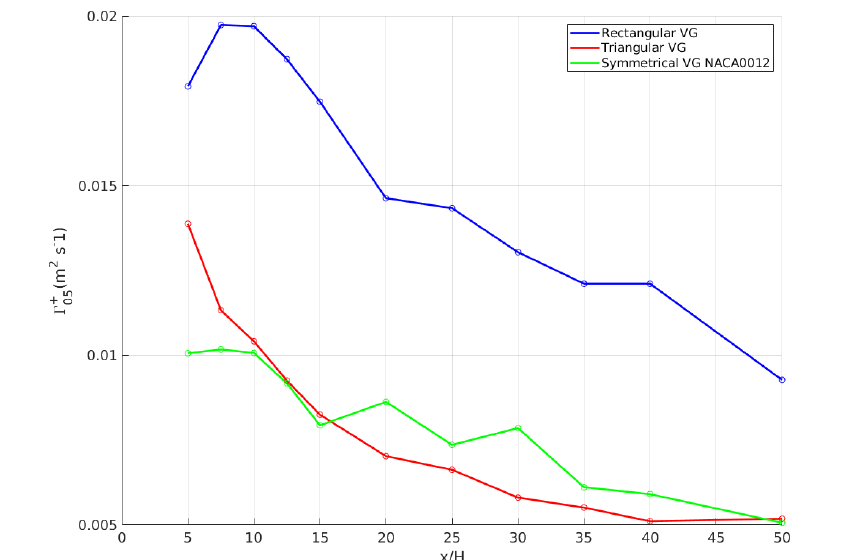
Figure 15. Vortex strength development analyzed with the mean positive circulation parameter Γ +